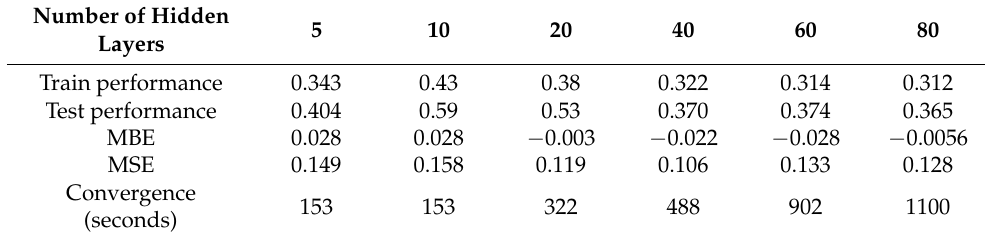
Table 10. The impact of number of hidden layers variation (in the case of the 2nd network configuration). Number of